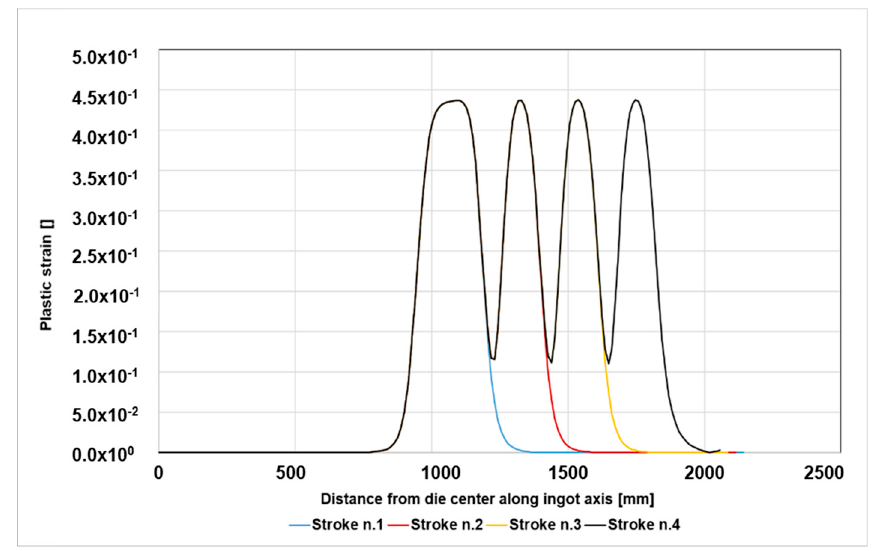
Figure 5. Evolution of plastic strain as a function of length at 1200 °C, Sb 0 = 300 mm, reduction = 25%, ingot diameter equal to 300 mm, pitch 90%.